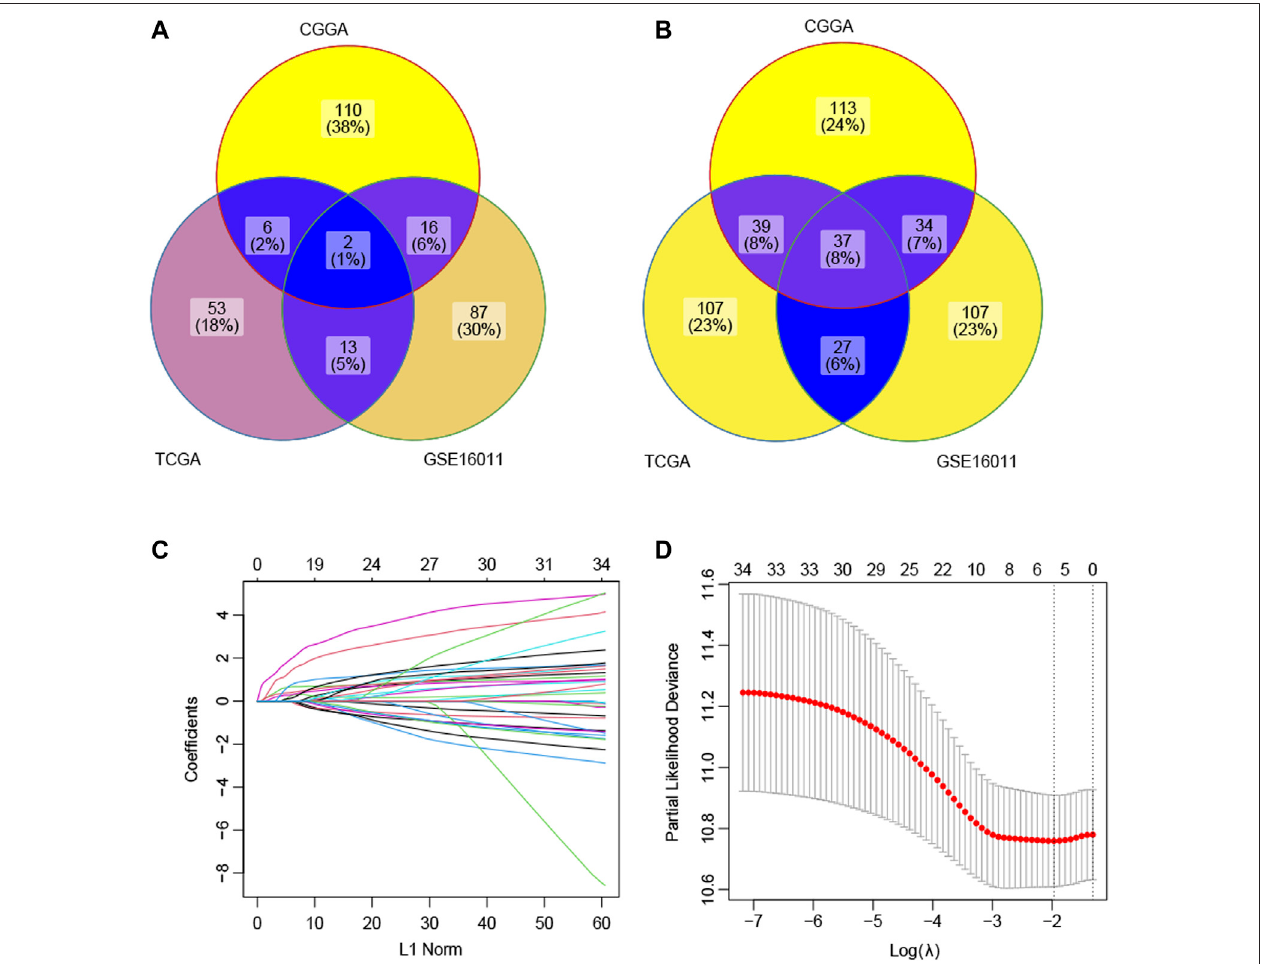
FIGURE 1 | Selection of the prognostic ECM genes by the lasso method. (A) Intersection of the candidate protective genes. (B) Intersection of the candidate risky genes. (C) Lassocoef fi cientpro fi lesof39genesweregeneratedbycomparingwiththe λ .Followingthechangeof λ ,thecoef fi cientsoftheunimportantgenesagainstthe L1-norm(regularizationterm)inthemodelwillbereducedtozero.Thenumberofcurvesisthenumberofgeneswithnon-zerocoef fi cientsatthecurrent λ . (D) Thisplotis toshowthecross-validationcurvealongwithupperandlowerstandarddeviation.Theleftverticallineindicatesthegenenumberwhenthevalueof λ givesaminimal meansquarederror(MSE).Therightverticallineindicatesthegenenumberwhenthecross-validatederroriswithinonestandarderroroftheminimum.Basedonthe fi rst vertical line, the model included fi ve genes with a non-zero prediction value.